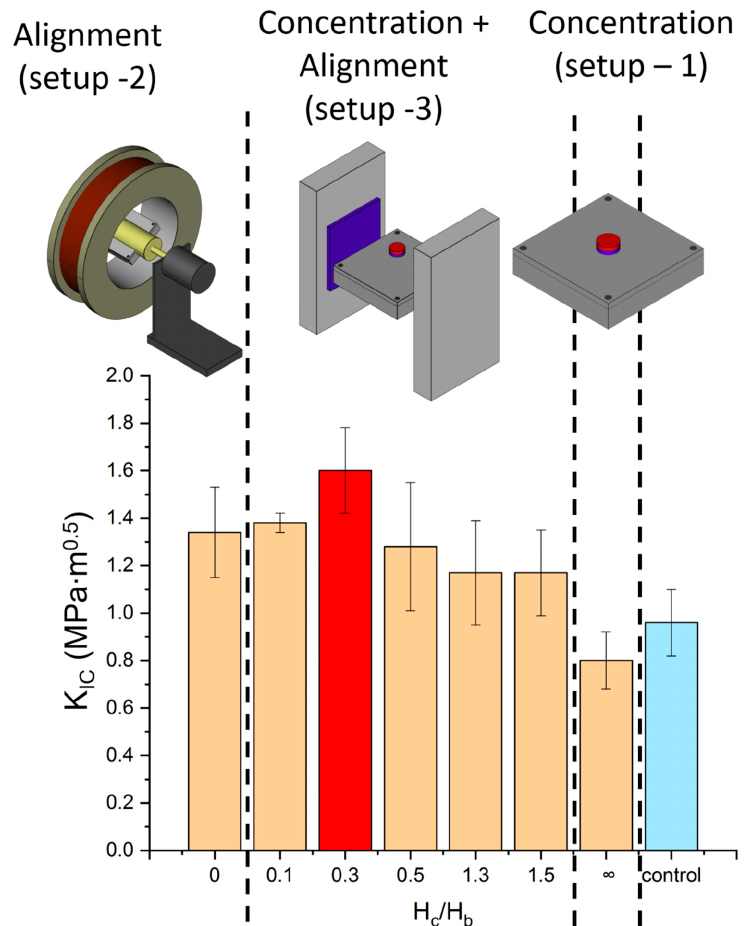
Figure 9. Fracture toughness of 10 wt % MGF/epoxy composites measured after using different magnetic configurations during the curing process. The horizontal axis represents the ratio between the concentrating field acting along the Z -axis of the specimen ( H c ) and the bias field acting along the X -axis ( H b ). A ratio of 0 indicates curing without a concentrating field (inside a solenoid as in setup 2), whereas a ratio of infinity indicates curing without any bias field (setup 1). The red column designates the value of H c /H b that maximized fracture toughness. The blue column (control) indicates curing in the absence of magnetic field (uniformly distributed and randomly oriented fibers).